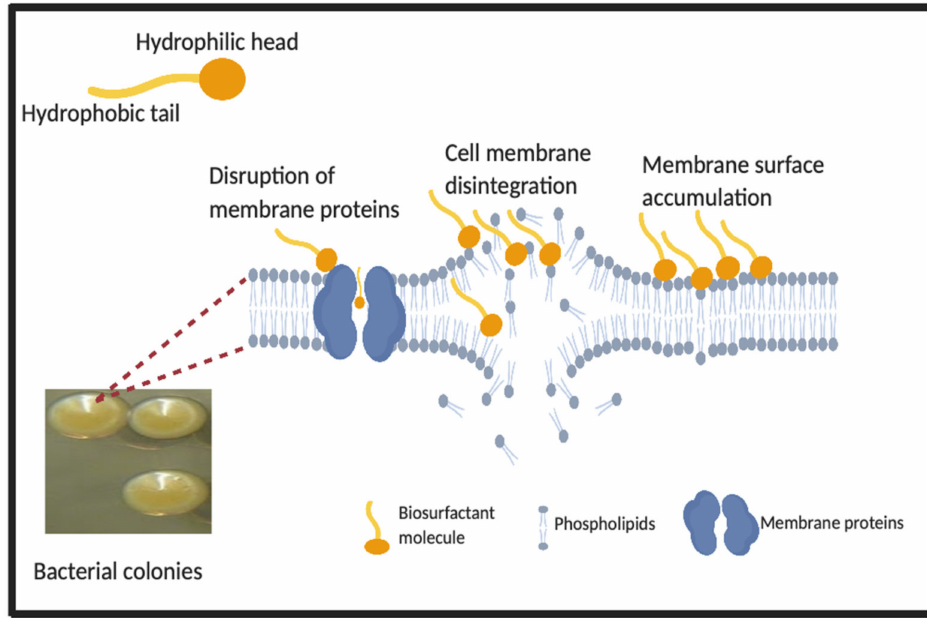
Figure 2. Theoretical interactions between biosurfactant molecules and bacterial cells. Primary mechanisms; disruption of cell membrane and proteins responsible for essential function. Figure adapted from [19,113] with permission from MDPI for [113], 2018 and created with